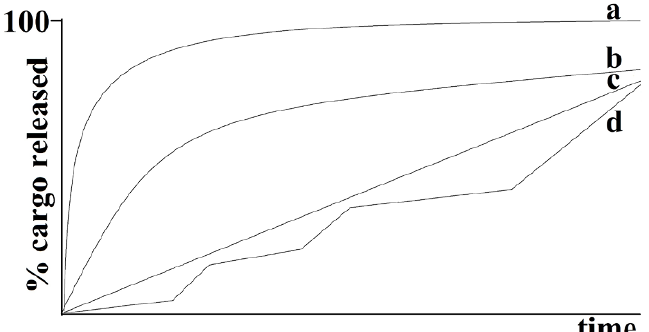
Figure 4. Cargo releasing profiles dependent on the method of functionalization.